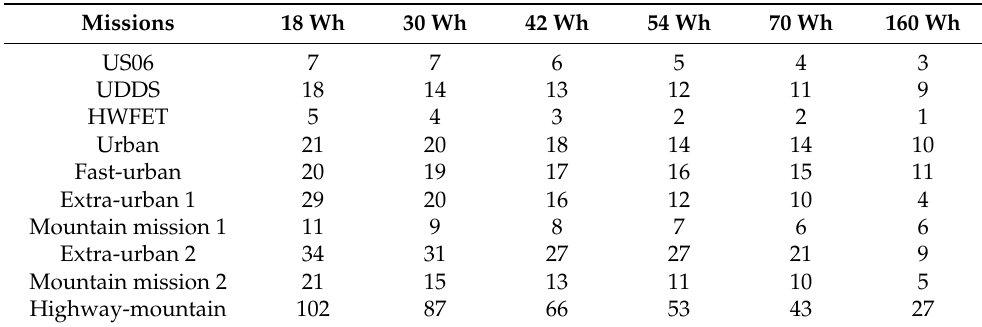
Table 8. Number of Diesel engine starts, approximated to the nearest integer, when speed is higher than the Upper Speed Limit (USL), as a function of NZ sizing (expressed in Wh). Missions 18